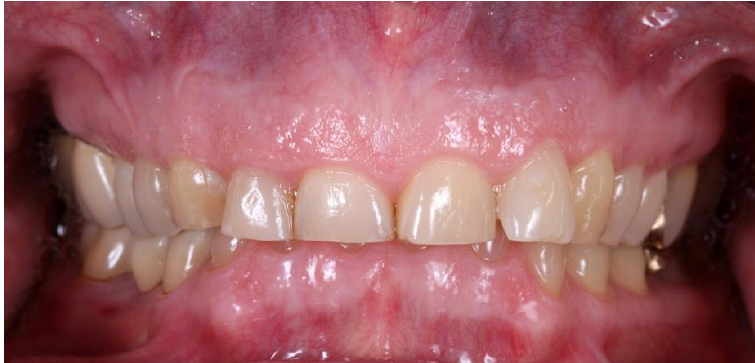
Figure 5. Case 2—Dental arches of a patient with parafunctions.